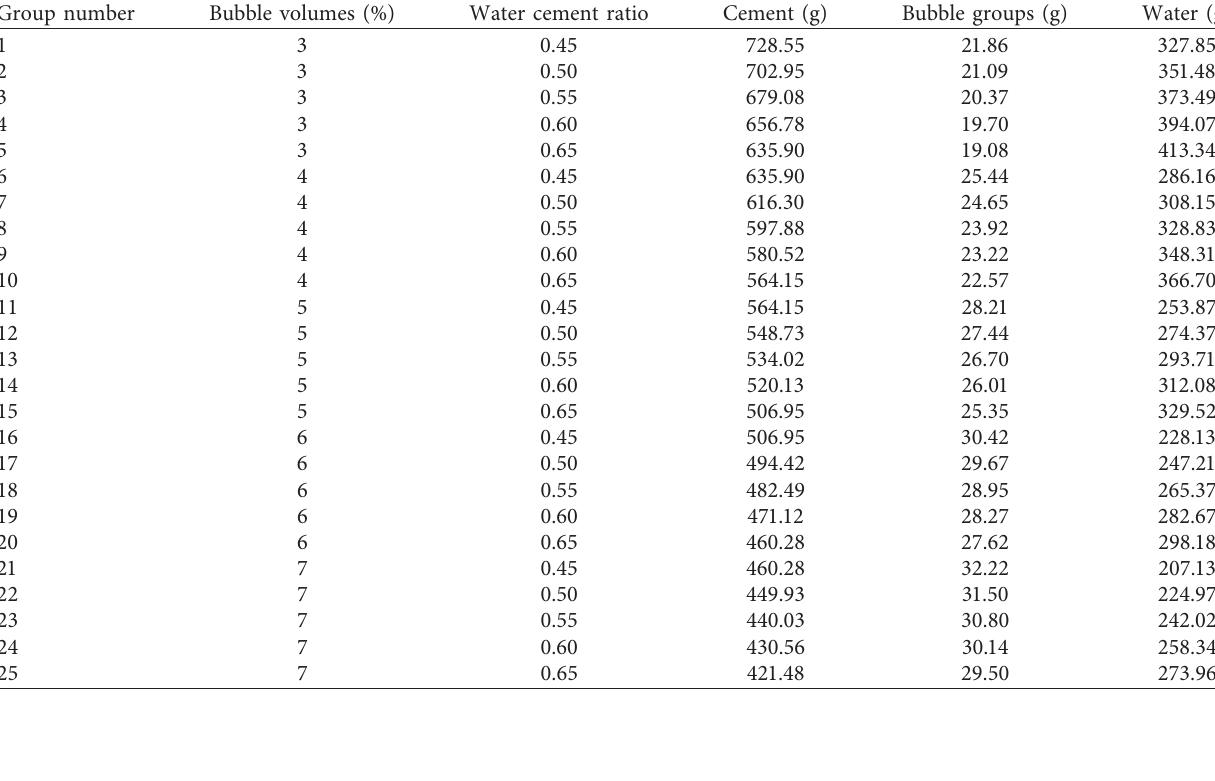
Table 5: Mixture ratio data of ordinary foam concrete.